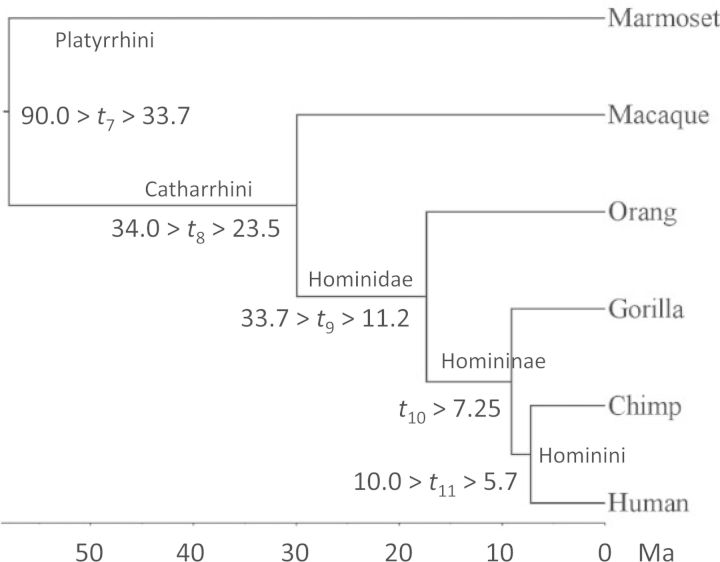
Phylogeny of six primate species. Fossil calibrations are shown next to the nodes on the tree. The joint bounds (for nodes 7, 8, 9, and 11) are implemented as soft uniform bounds with a sharp minimum (1% of tail probability on the left) and a soft maximum (5% of tail probability on the right) (Yang and Rannala 2006, figure 2). The minimum bound (on node 10) is implemented using the truncated Cauchy distribution (Inoue et al. 2010).